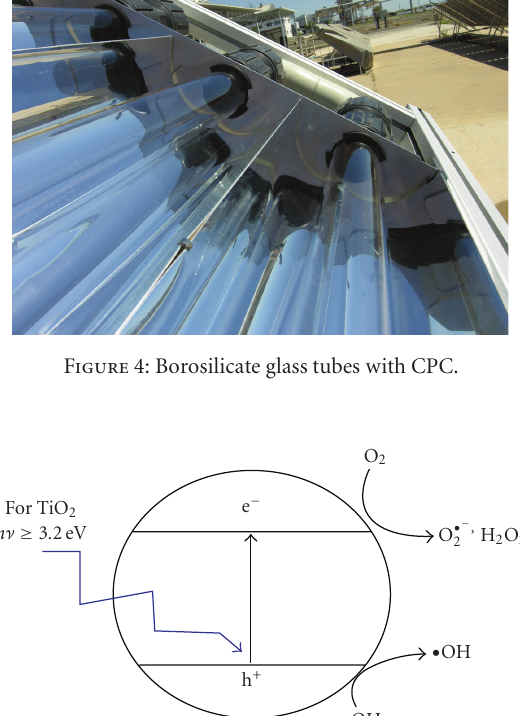
Figure 5: Schematic representation of the mechanism of photo- catalysis on titanium dioxide